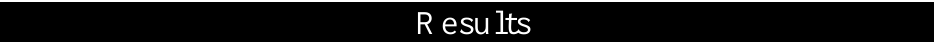
Baseline Characteristics of Survey Respondents Compared with all Students Eligible for the Survey Dissertation